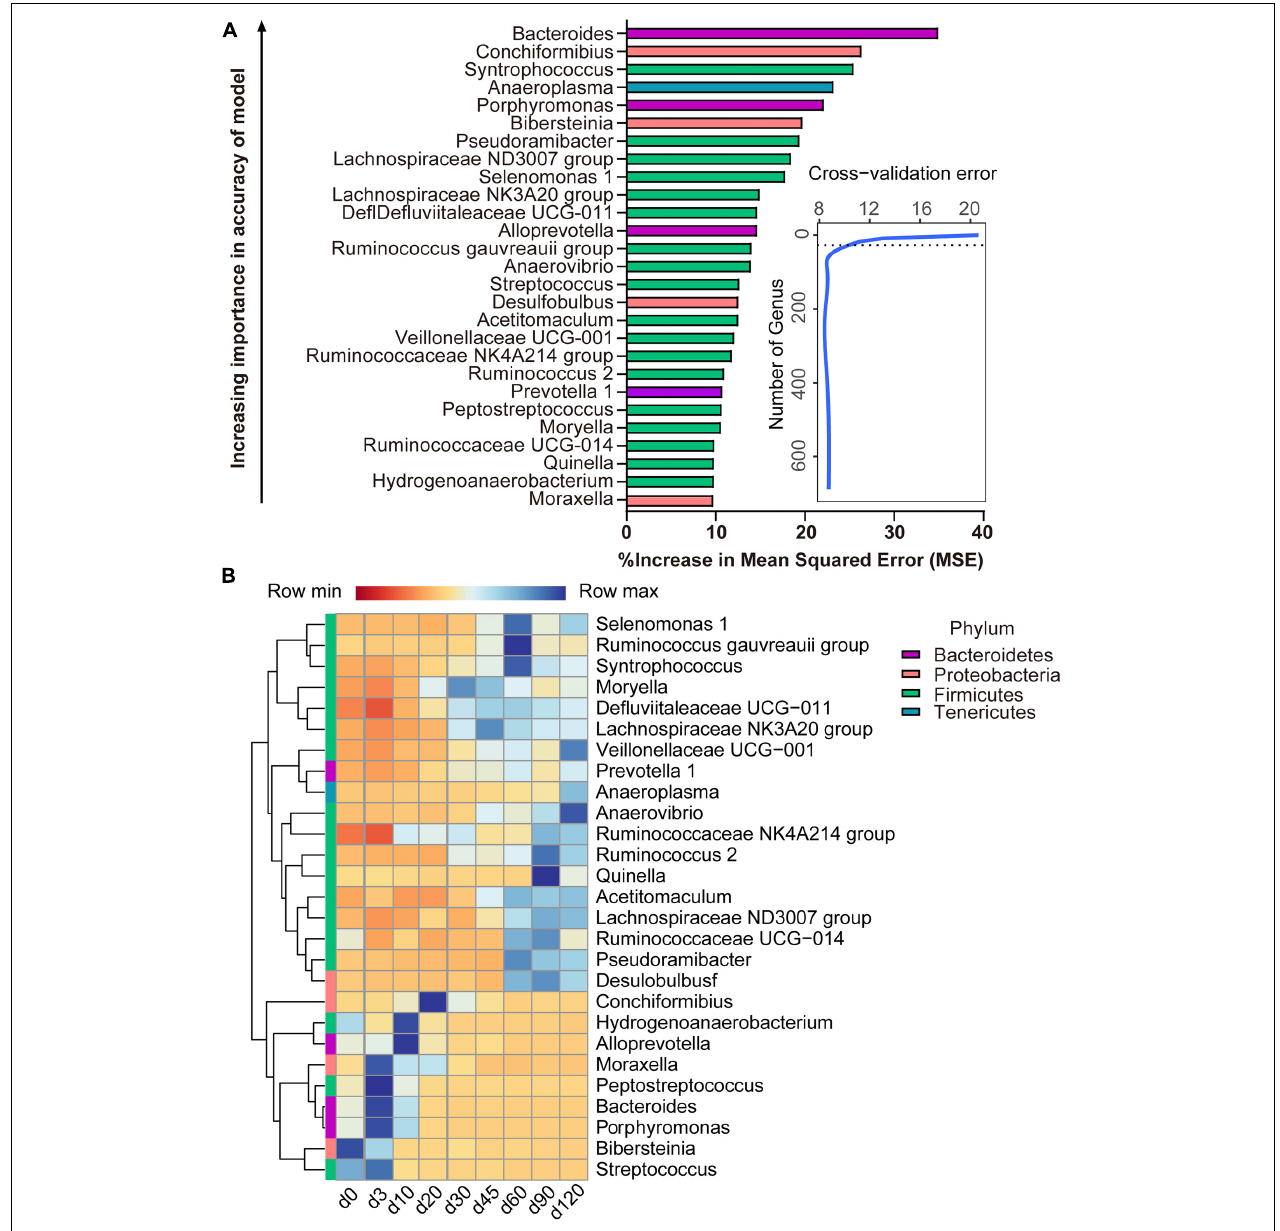
FIGURE 5 | Bacterial taxonomic biomarkers of lamb age and the rumen microbiota gradually stabilize. (A) The top 27 biomarkers of bacterial genera were identified by applying RandomForest regression of their relative abundances in lambs against chronological age. Ranking in descending order of importance to the accuracy of the model was to determine biomarker taxa. The insert illustrates the result of the 10-fold cross-validation error. (B) Heatmap of changes over ages showing the relative abundances of the top 27 age-predictive biomarkers for bacterial